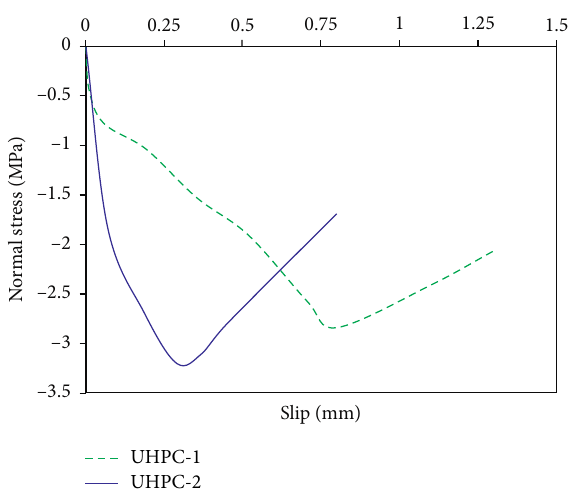
Figure 16: Slip-normal stress curves.